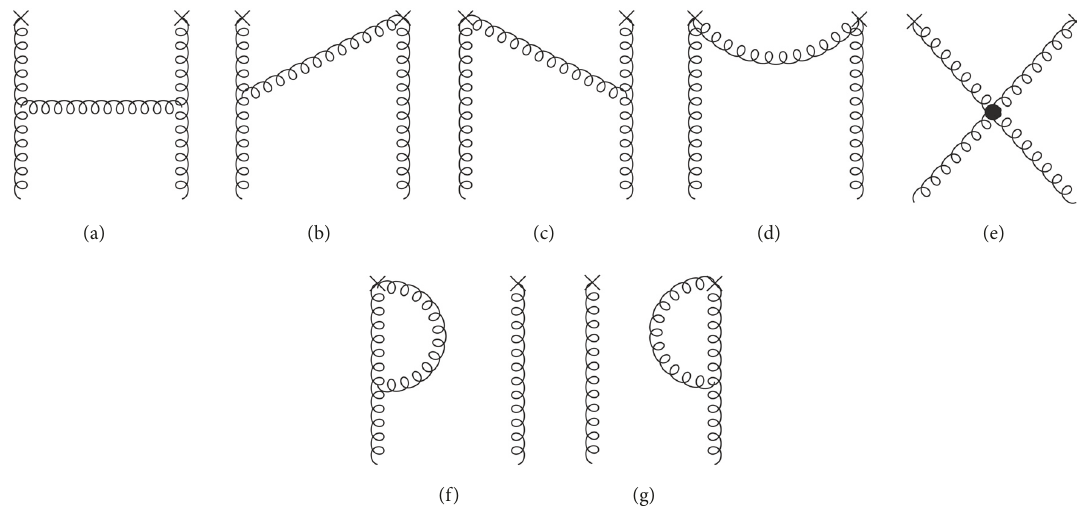
Figure 8: One-loop corrections to a gluon quasidistribution, without the Wilson line. The symbol “ × ” denotes the nonlocal vertex from the operator. Source: [136], reprinted with permission by the Authors (article published under an open access license).